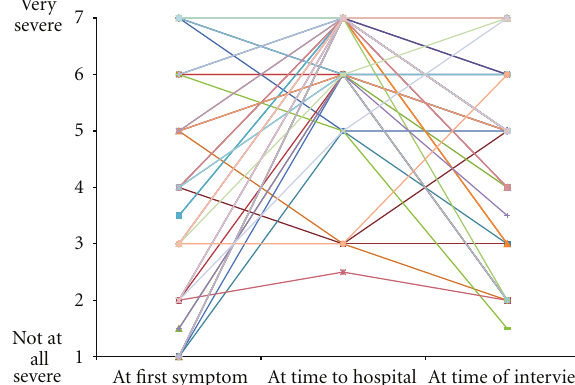
Figure 2: Patterns of severity ratings for individual participants over time.